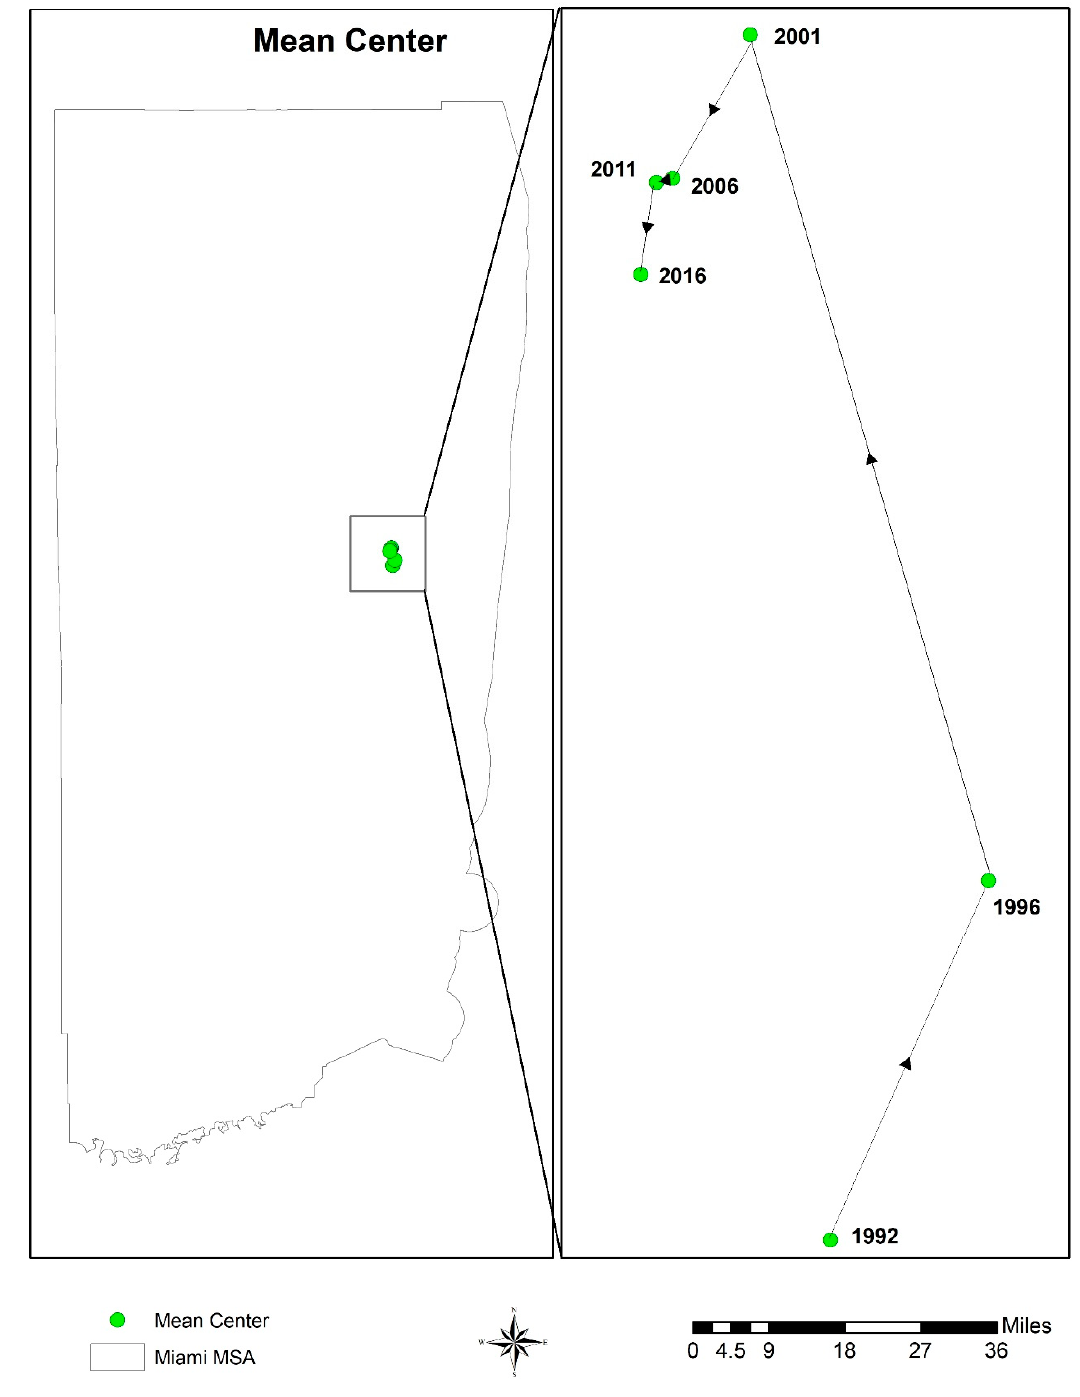
Figure 9. Change of direction in the mean center in Miami MSA.